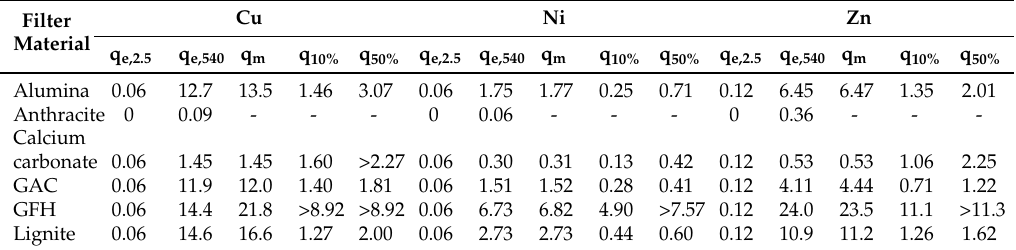
Table 2. Comparison of different sorption capacities; batch experiments: highest values measured (q e ) for two initial concentrations (mg/L) at pH 5 with the rotary shaker without a buffer and calculated using the Langmuir isotherm model (q m ); column experiments: at 10% breakthrough point (q 10% ) and at 50% breakthrough point (q 50% )—all values in